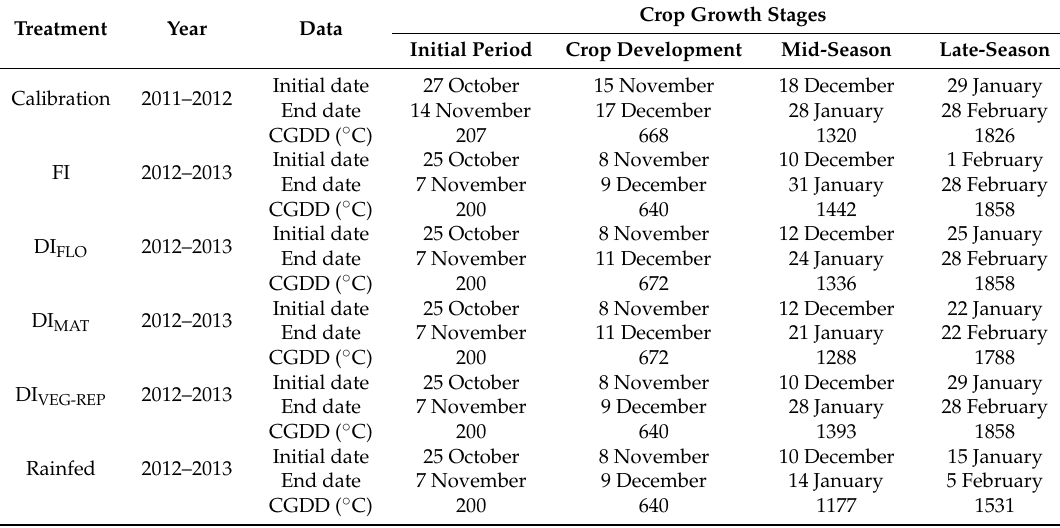
Table 3. Crop growth stages dates and accumulated growth degree days (CGDD) for each experimental season.